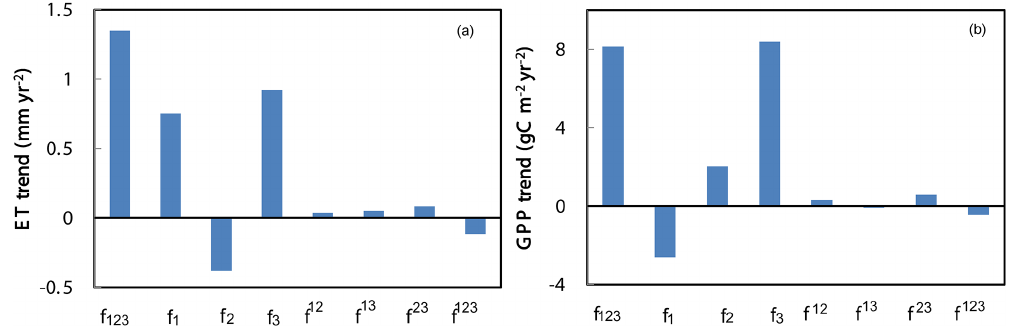
Figure 12. (a) Contributions of climate change, atmospheric CO 2 enrichment, and agronomic management to ET and (b) contributions to GPP